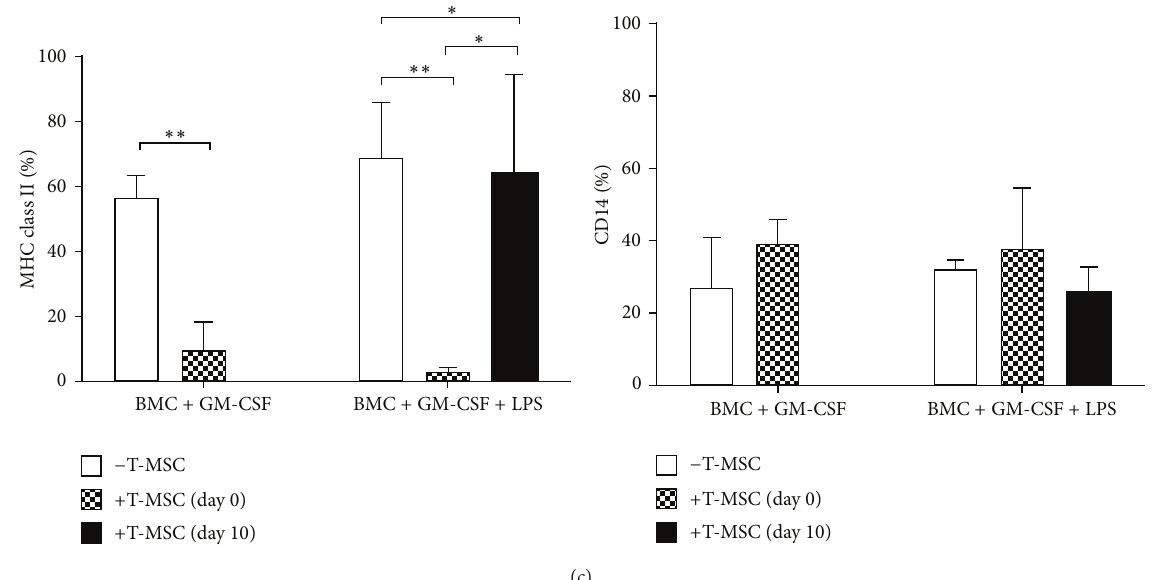
Figure 1: T-MSCs inhibit differentiation and maturation of DCs under coculture conditions. Bone-marrow- (BM-) derived monocytes (BMCs) isolated from 8-week-old BALB/c mice were incubated with of granulocyte-macrophage colony-stimulating factor (GM-CSF) (20 ng/mL) for 12 days to induce differentiation into dendritic cells (DCs). (a) Lipopolysaccharide (LPS) (1 𝜇 g/mL) was added for the last 2 days to induce DC maturation. (b) GM-CSF treatment induced expansion of CD11b + cells ( ∗∗ 𝑃 < 0.01 ). (c) Tonsil-derived MSCs (T-MSCs) added at day 0, but not at day 10, inhibited upregulated expression of CD80 ( ∗ 𝑃 < 0.05 ) and CD86 ( ∗∗ 𝑃 < 0.01 ) on mature DCs by direct contact. Upregulated major histocompatibility complex (MHC) class II expression on immature ( ∗∗ 𝑃 < 0.01 ) and mature DCs ( ∗∗ 𝑃 < 0.01 ) was reduced by T-MSCs, but CD14 expression was not